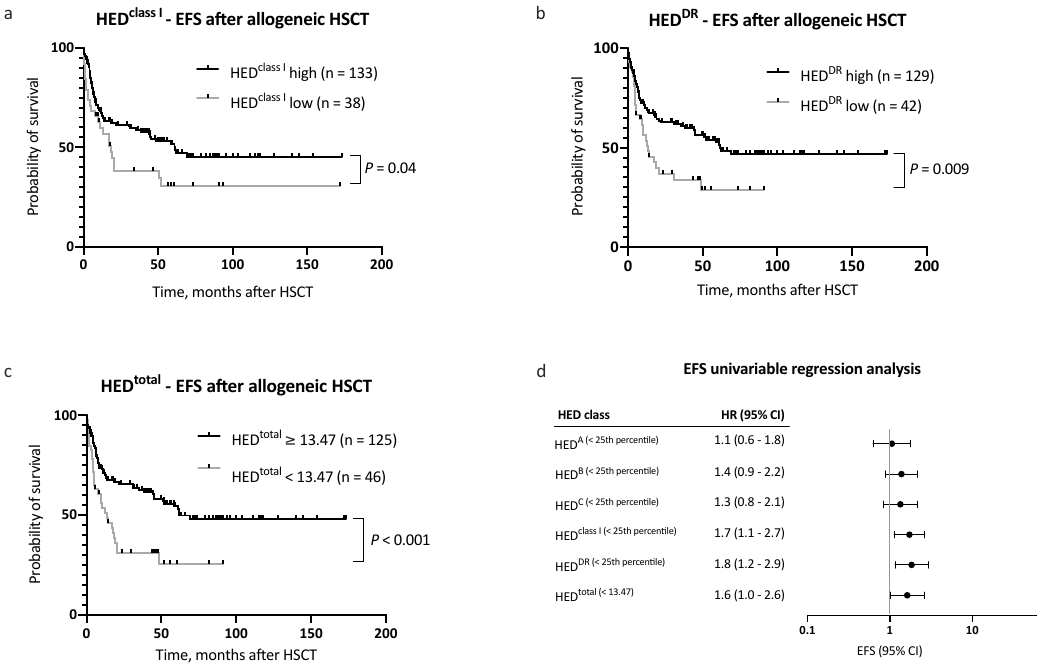
Figure 3. Analysis of event-free survival. ( a – c ) Kaplan–Meier analysis of event-free survival (EFS)